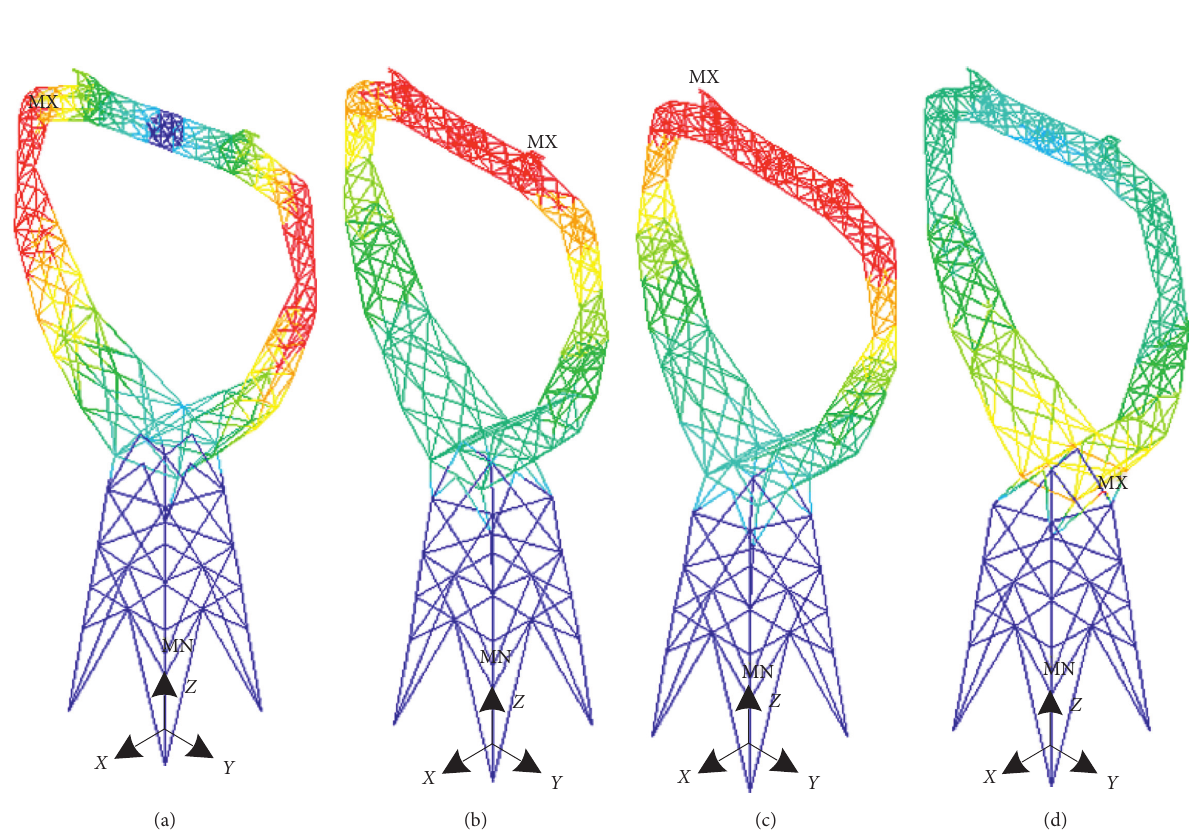
Figure 5: The modal shapes of the transmission tower. (a) The first-order modal shape. (b) The second-order modal shape. (c) The third- order modal shape. (d) The fourth-order modal